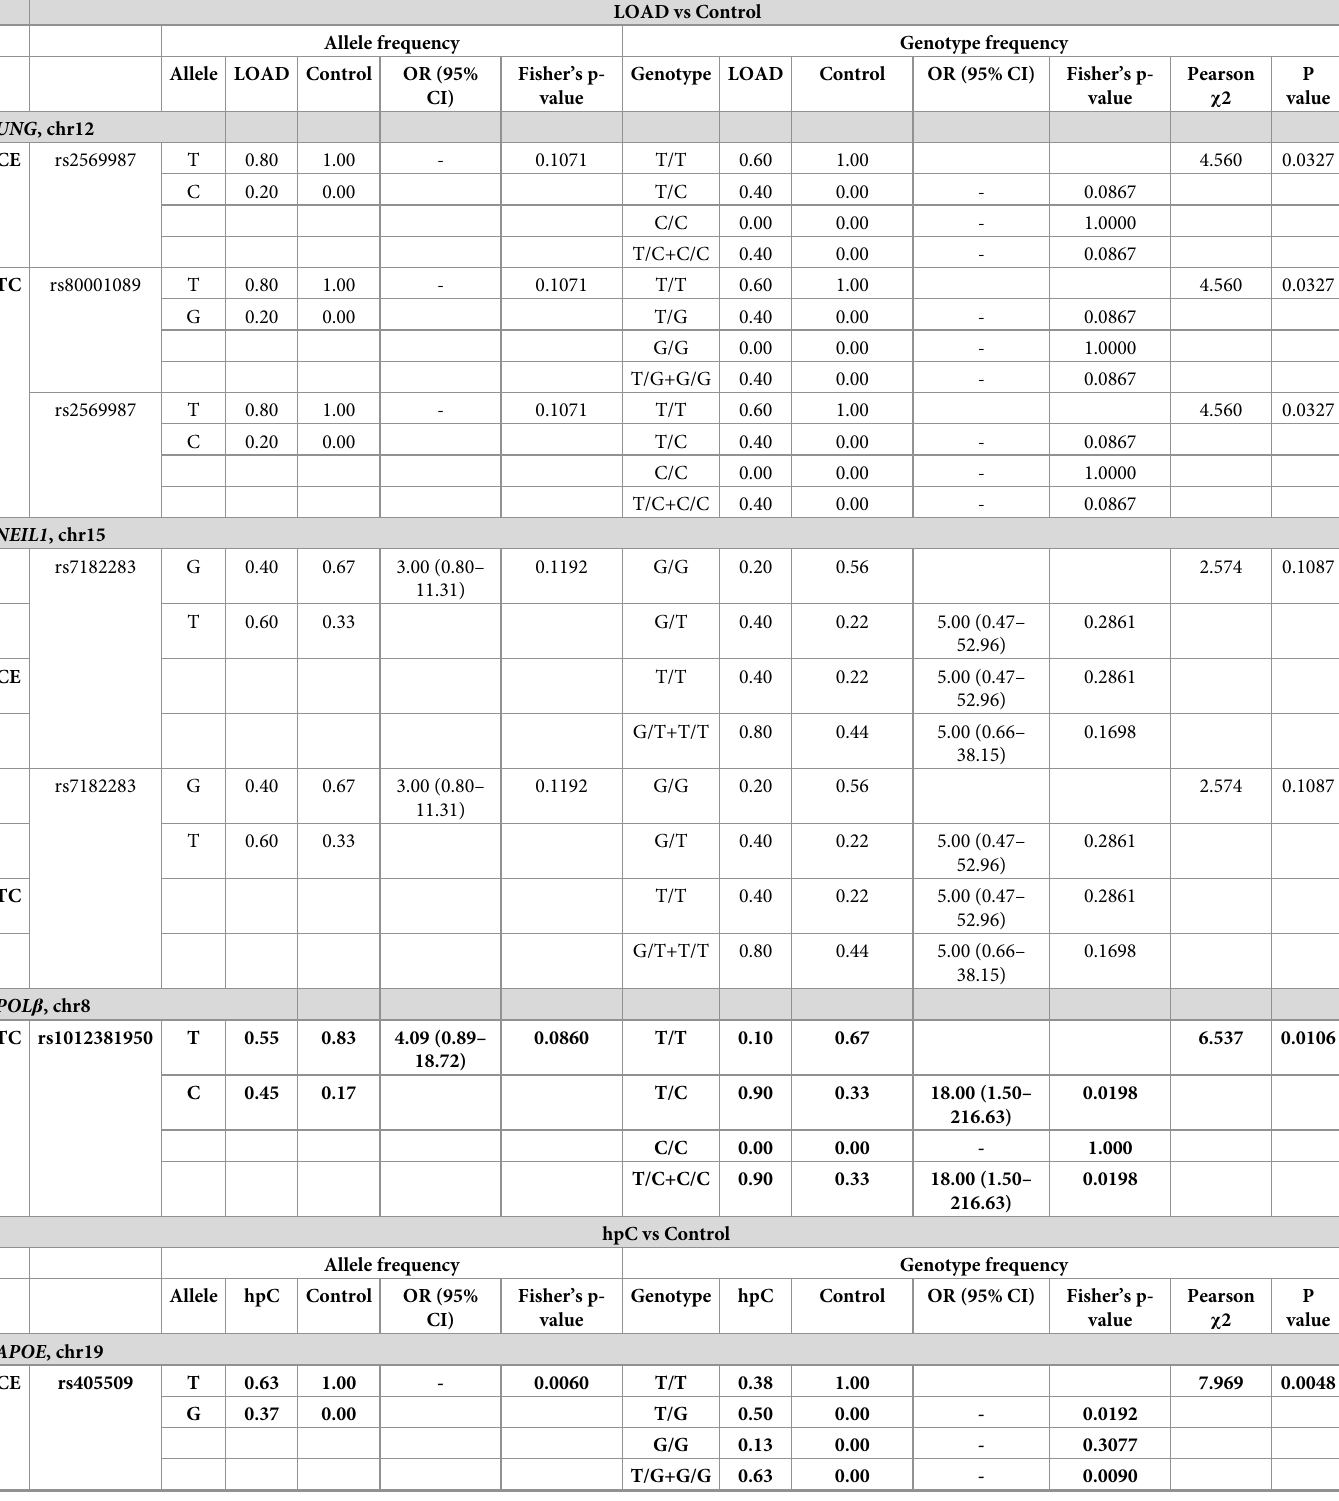
Table 9. Comparison of allele and genotype frequencies of UNG , POL β , NEIL1 and APOE in CE and TC samples of same LOAD patients, hpC and age-matched cog- nitively normal controls (LOAD = 10, hpC = 8, Control =